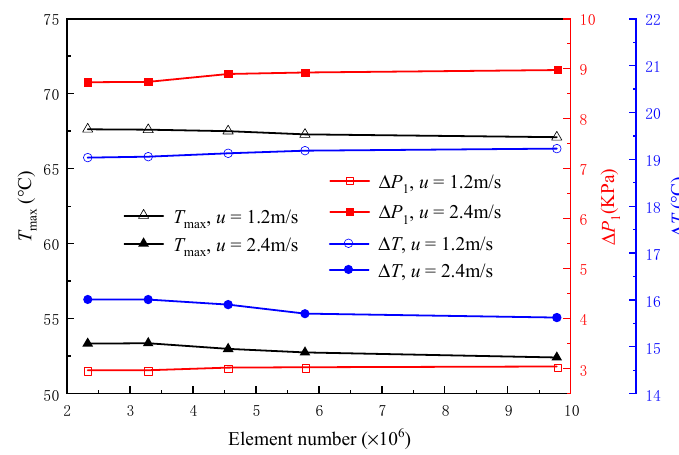
number of about 5.78 × 10 6 is selected for all numerical simulations.